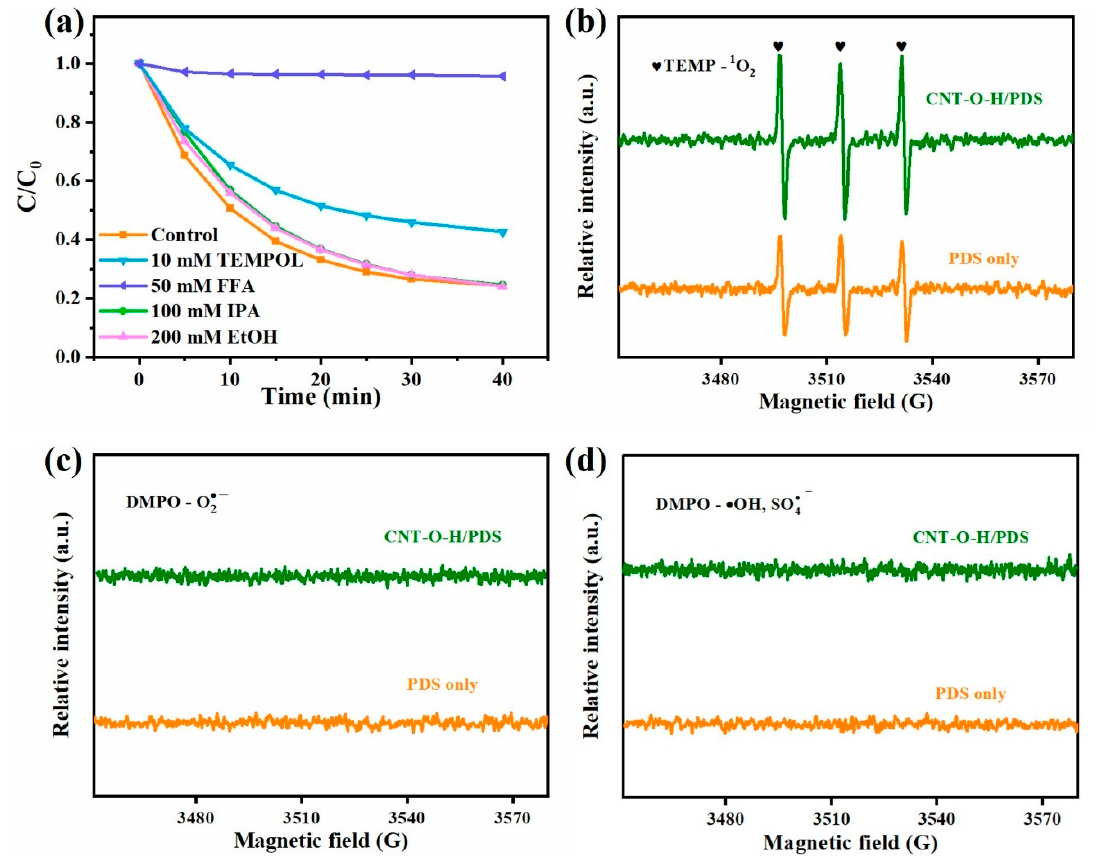
Figure 9. Quenching experiments ( a ) and EPR spectra ( b – d ) for the CNT-O-H/PDS system.